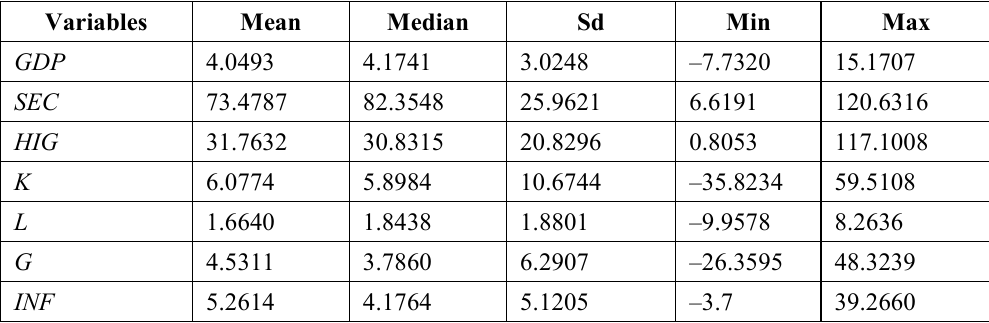
Table 2. Summary of Descriptive